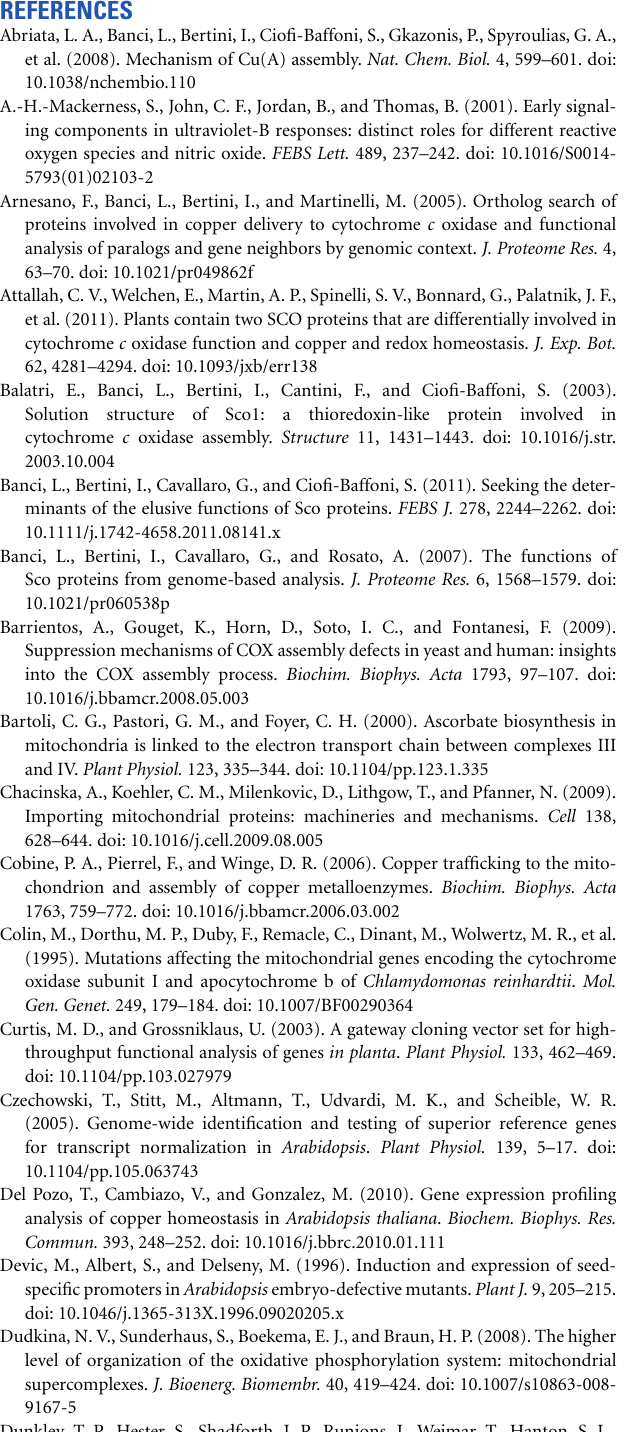
Supplementary Figure 3 | Analysis of steady-state COX2 levels in the WT and hcc2-2 KO mutants. MCF (50 μ g each, normalized to WT CSA levels) prepared from liquid cultures of etiolated seedlings (WT and hcc2-2 / hcc2-2 mutants) were separated in a 15% SDS gel for Western blot analysis. Immunological detection of COX2 and VDAC1 was performed successively on the same membrane. VDAC1 was detected as the loading control for equal amounts of mt protein. The Western blot analysis was performed three times with two independent sets of protein extracts, producing the same